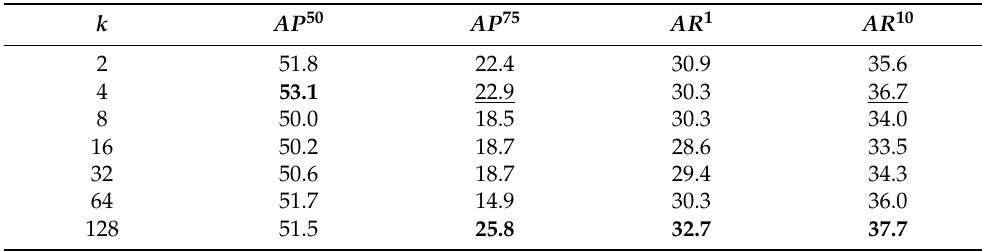
Table 4. Comparison of test results of different k . The underlined numbers indicate sub-optimal, the bolded numbers indicate optimal.